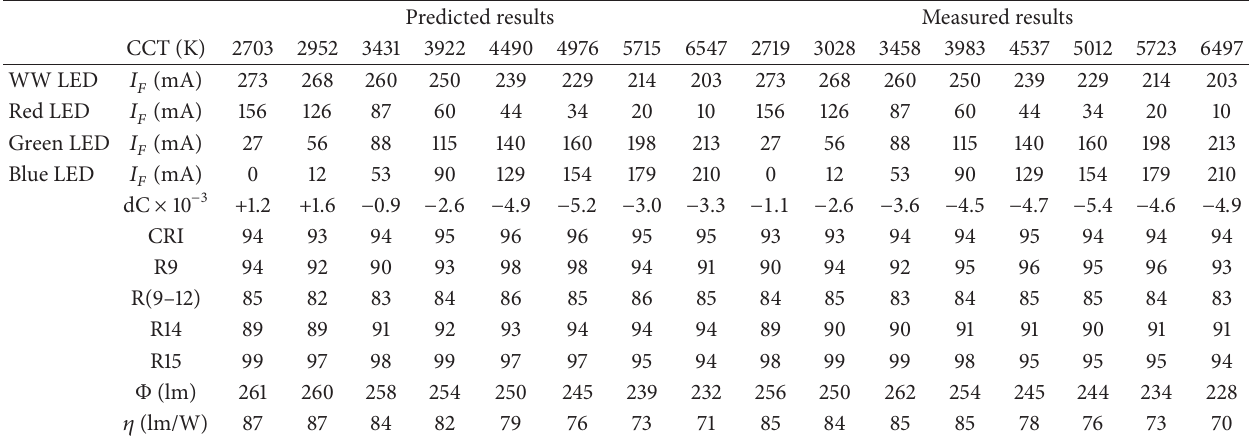
Table 2: The predicted and measured results of the white-light LED cluster at 𝑇 𝑎 = 45 ∘ C. Predicted